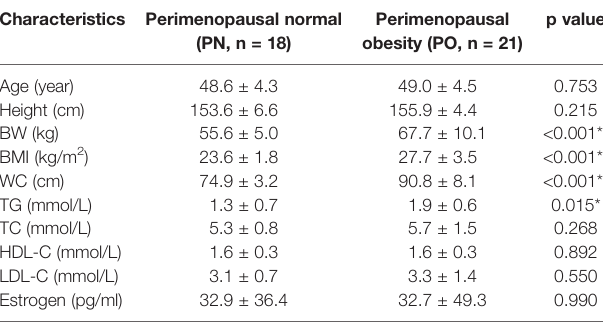
TABLE 1 | Clinical characteristics of the participants in two